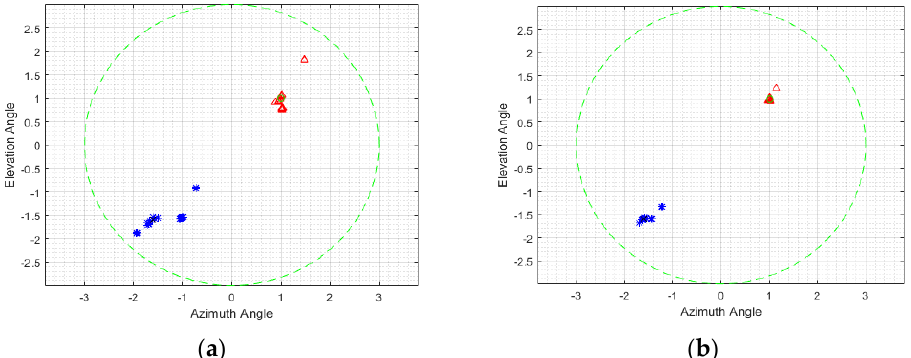
Figure 4. Scatter plot of angle estimation of real target (*) and decoy ( Δ ) The green circle is 3 dB width of the sum beam (ground truth locations of decoy ( O ) and real target (x ) ) . ( a ) SNR = 20 dB; ( b ) SNR = 30 dB.